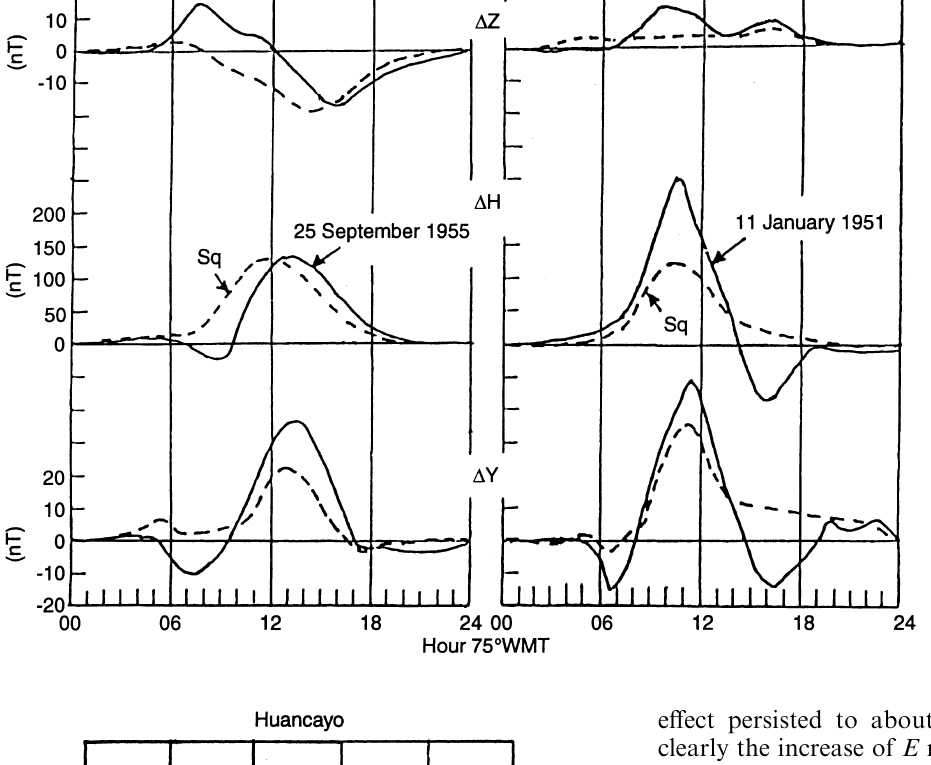
Fig. 6. Daily variations of H , Y and Z fields on counter electrojet days compared with correspond- ing Sq variations